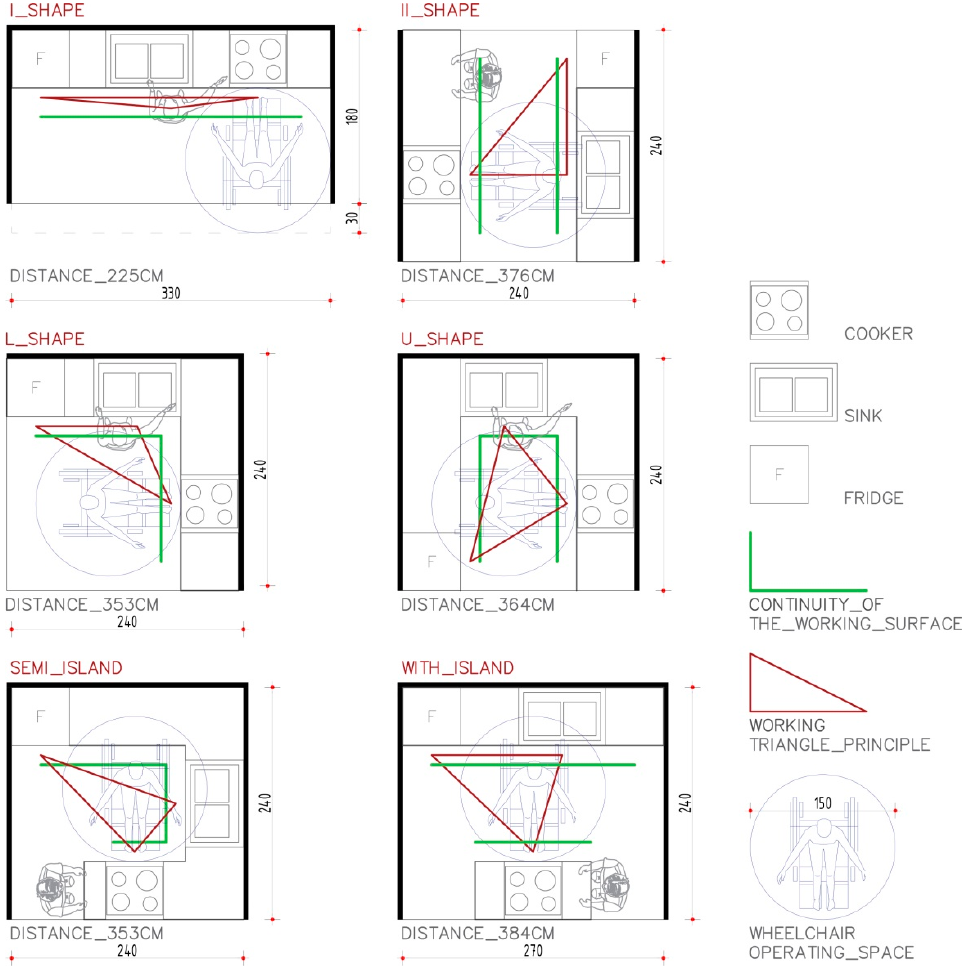
Figure 1. Six characteristic types of kitchen related to the distance of countertop continuity and optimization of 3 main kitchen elements that create a working triangle. optimization of 3 main kitchen elements that create a working